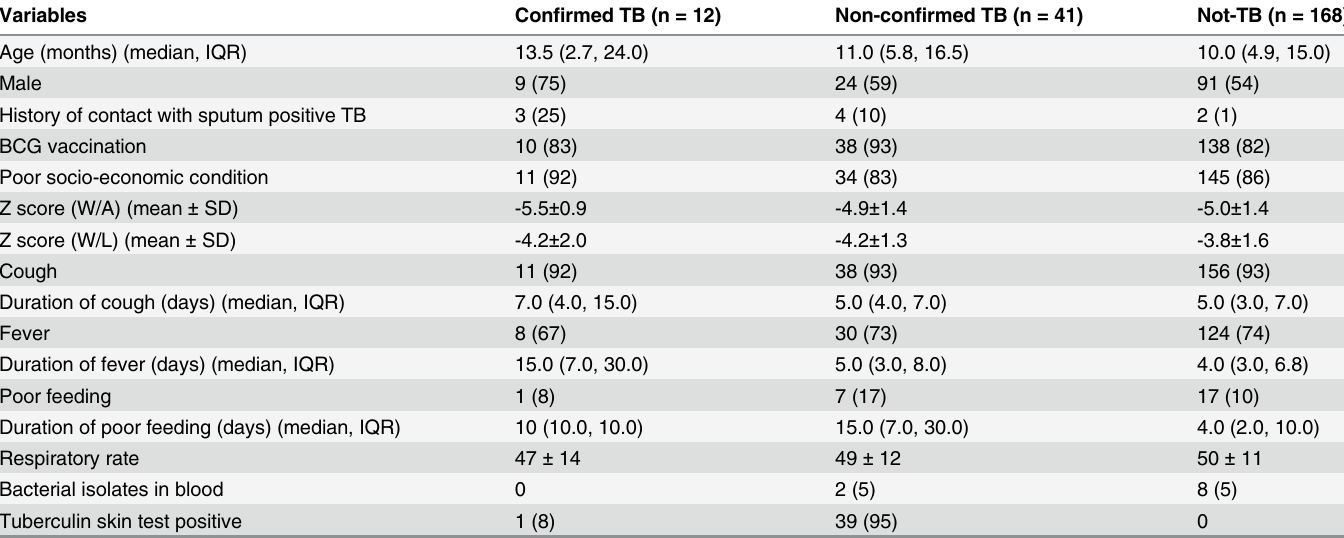
Table 4. Baseline characteristics of study participants according to diagnostic